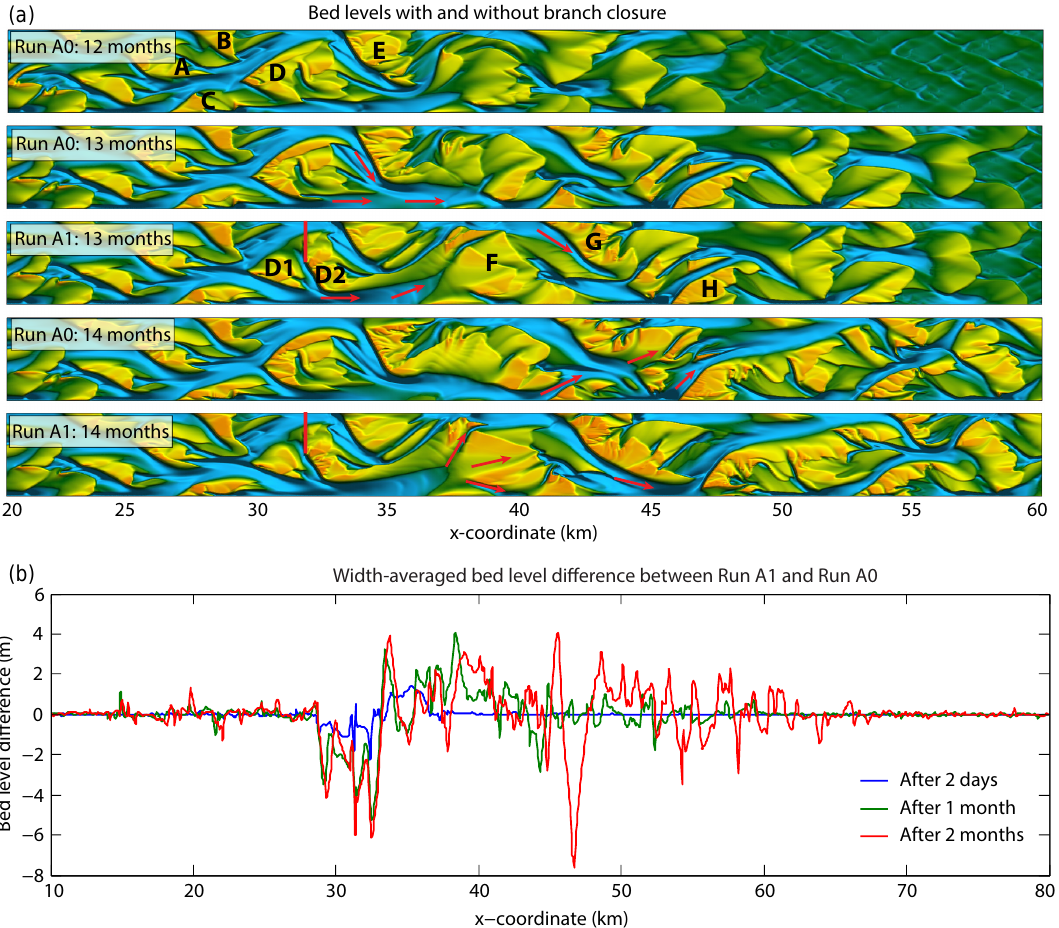
Figure 8. Evolution of the braided channel network and bar pattern in Run A1 with branch closure: (a) time series of the bed level for Run A1 (with dam) and Run A0 (no dam) and (b) width-average bed level difference between Run A1 and Run A0, with negative values indicating more incision in Run A1 than in Run